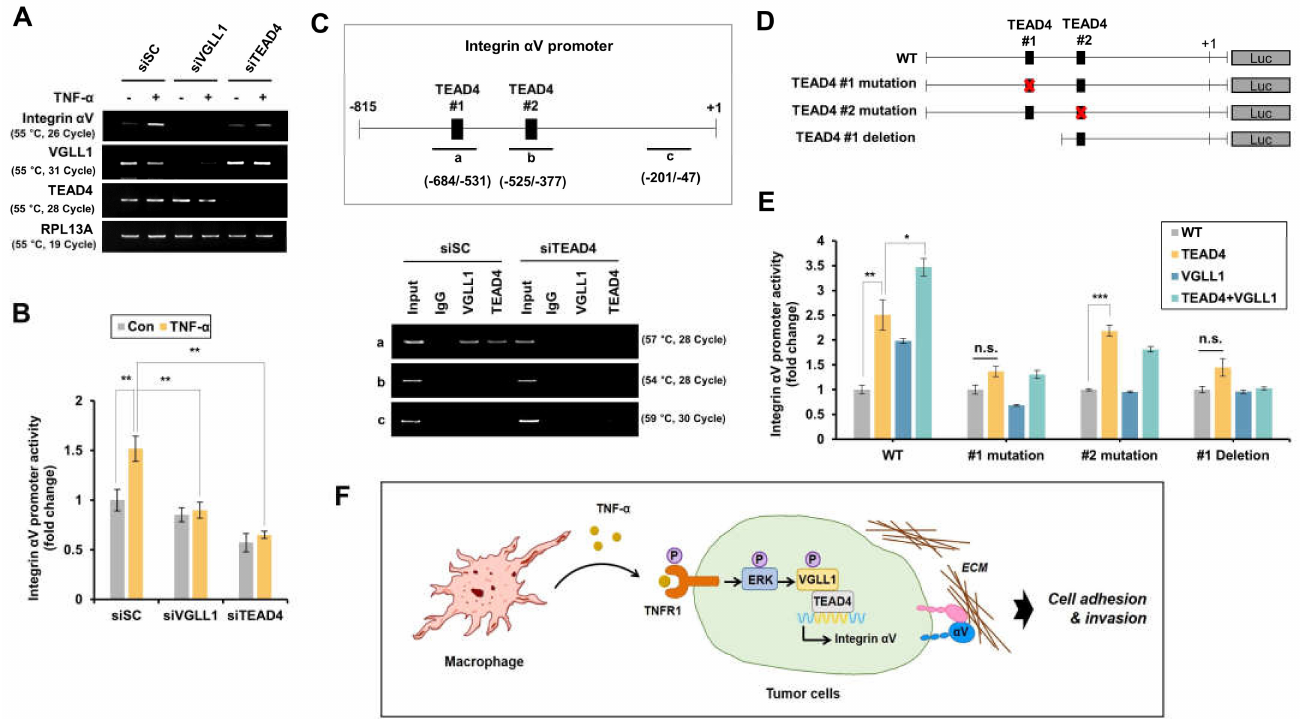
Figure 5. TNF − α − induced integrin α V transcription is regulated through TEAD4. ( A ) AGS cells were treated with siScramble, siVGLL1, or siTEAD4, and then treated with TNF − α for 24 h. The mRNA expression of VGLL1, TEAD4, integrin α V, and RPL13A was analyzed by RT − PCR (three replicates). ( B ) The effect of VGLL1 and TEAD4 on integrin α V promoter activity. AGS cells were transfected with integrin α V − Luc and Renilla − Luc for 24 h and then cells were treated with siScramble, siVGLL1, or siTEAD4 for 24 h. After serum starvation for 24 h, the cells were treated with TNF − α for 24 h. The promoter activity of integrin α V was normalized by Renilla − Luc ( n = 3). ( C ) In AGS cells treated with siScramble or siTEAD4, the TEAD4 binding site in the integrin α V promoter was analyzed by ChIP assay (two replicates). ( D ) The construction of various luciferase reporters under the control of the integrin α V promoter. ( E ) Integrin α V promoter activity containing modified TEAD4 − binding sites was measured in AGS cells ( n = 3). ( F ) Model of TNF − α − induced integrin α V expression. Student’s t − tests was used for statistical analyses. The bars indicate the S.D.; the asterisks denote significant differences (*** p < 0.001, ** p < 0.01, * p < 0.05) between the means of two